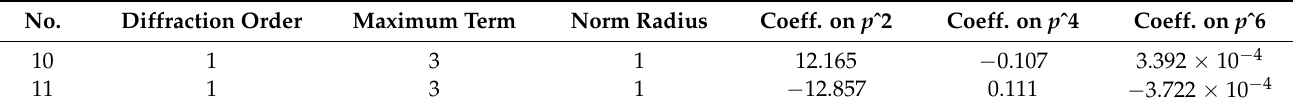
Table 3. Diffractive surface coefficient.